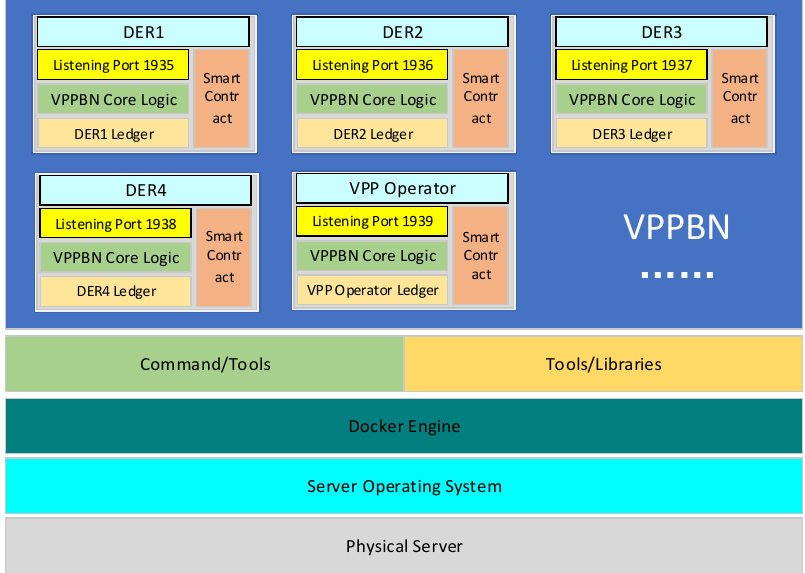
Figure 11. Experimental simulation